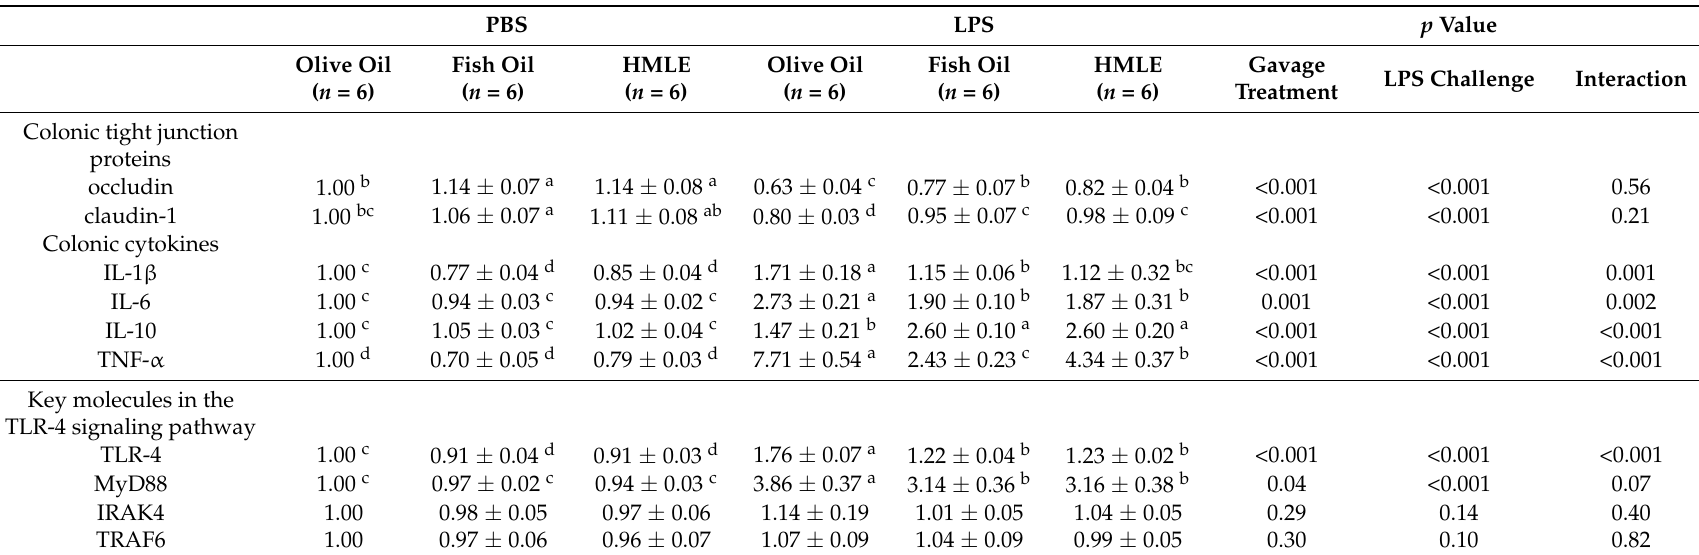
Table 5. Effects of different gavage treatments on colonic mRNA